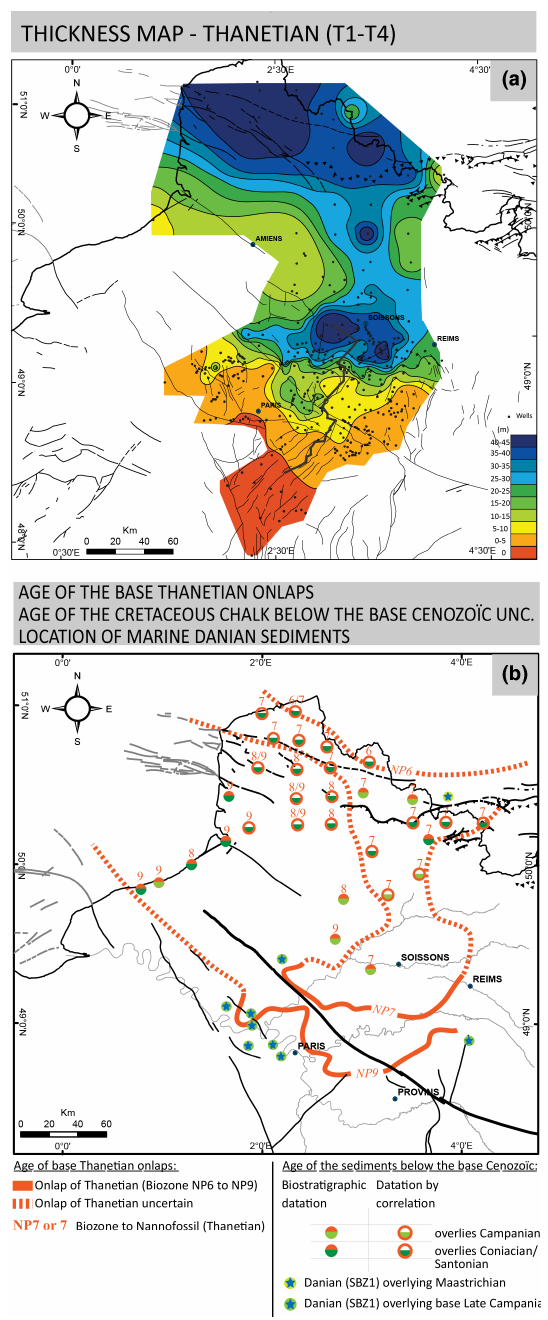
Figure 7. Upper Palaeocene sediment distribution in the Paris and Belgium (Bruxelles) basins. (a) Isopach map of the Thanetian cy- cle (T1–T4; data from this study and geological maps of France at the 1 : 50000 scale). (b) Age of the Thanetian onlaps and Upper Cretaceous (chalk) sediments below the base of the Cenozoic and the location of the marine Danian sediments (data from geological maps of France at the 1 : 50000